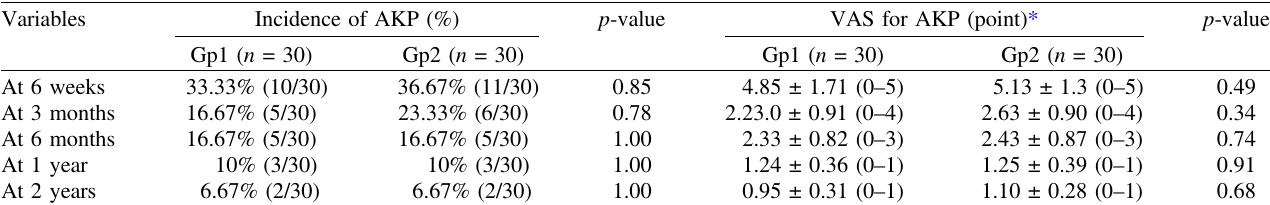
Table 2. Incidence of AKP and VAS for AKP.